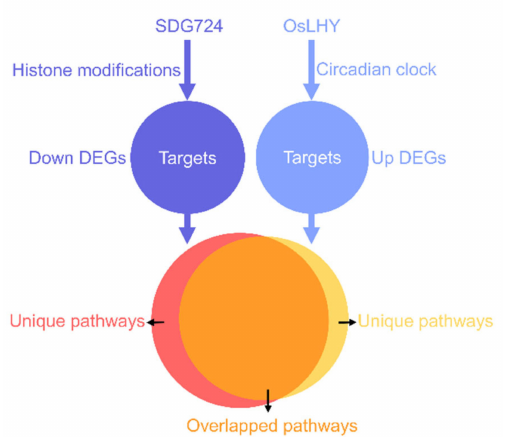
Figure 7. A simple model of the relationship between OsLHY and SDG724 . SDG724 and OsLHY might not work together on the same target gene. However, most of the KEGG pathways indirectly controlled by SDG724 and OsLHY merged, paving the way for revealing the interaction between the circadian clock and histone